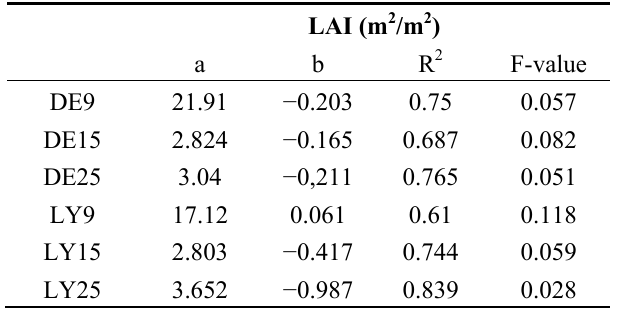
Table 3. LAI modeling through Daedalus ATM (DExx) reflectances and Lyzenga indices (LYxx) using different neigbohood window sizes around the sampling stations centre.